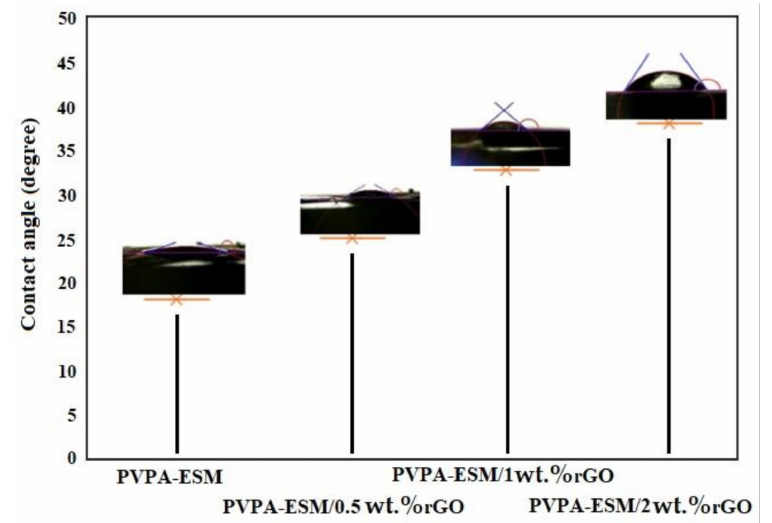
Figure 7. Contact angle measurements of the electro–spun PVPA–ESM/x wt.% rGO nanofibers with various rGO concentrations (x = 0, 0.5, 1 and 2